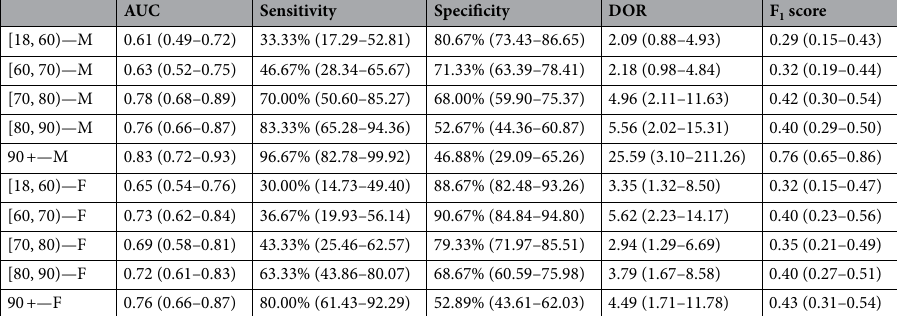
groups with patients above 90 years and the one with female patients between 18 and 59 years result less repre- sented than the other groups of patients due to lack of data. In conclusion, the AI model is trained with 6,382 ECGs (around 4,500 patients) and evaluated on ten different test sets, representing the ten different age-sex-spe- cific groups of patients. The age distribution between AF and SR data is balanced in all the datasets considered, as detailed in Supplementary Table S1. The experimental results are provided in Table 4. The ResNet model predicts AF in the different age-sex-specific groups of patients with different precisions. For male patients, the model